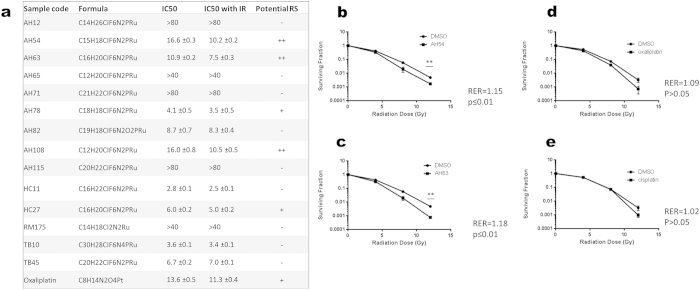
Cytotoxicity and radiosensitising activity of 14 Ru(II) compounds in DLD1 colorectal cancer cells.(a) IC50 data for Ru drugs screened without and with ionising radiation, assessed by proliferation assays. Error information indicates 95% confidence intervals. Those that displayed radiosensitising potential are marked ‘+’ for IC50 shift between 10 and 20% and ‘++’ for IC50 shift >40% (b–e) Clonogenic survival assays confirm significant radiosensitisation of DLD1 cells at 12 Gy by IC50 concentrations of (b) AH54 and (c) AH63, radiosensitisation by (d) oxaliplatin and (e) cisplatin does not reach significance. Statistical significances between clonogenic survival curves and radiation enhancement ratios (RER) were calculated as described in the Methods section of the main text.